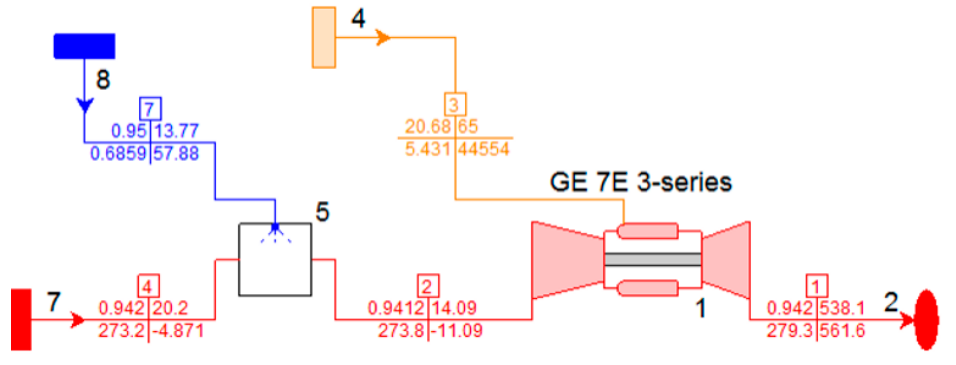
Figure 7. Gas turbine with evaporative inlet cooling.